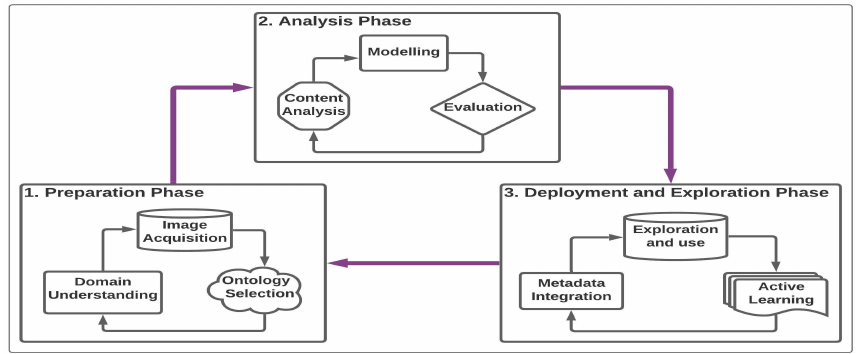
Figure 1. A three-phase-methodology for semantic enrichment of cultural